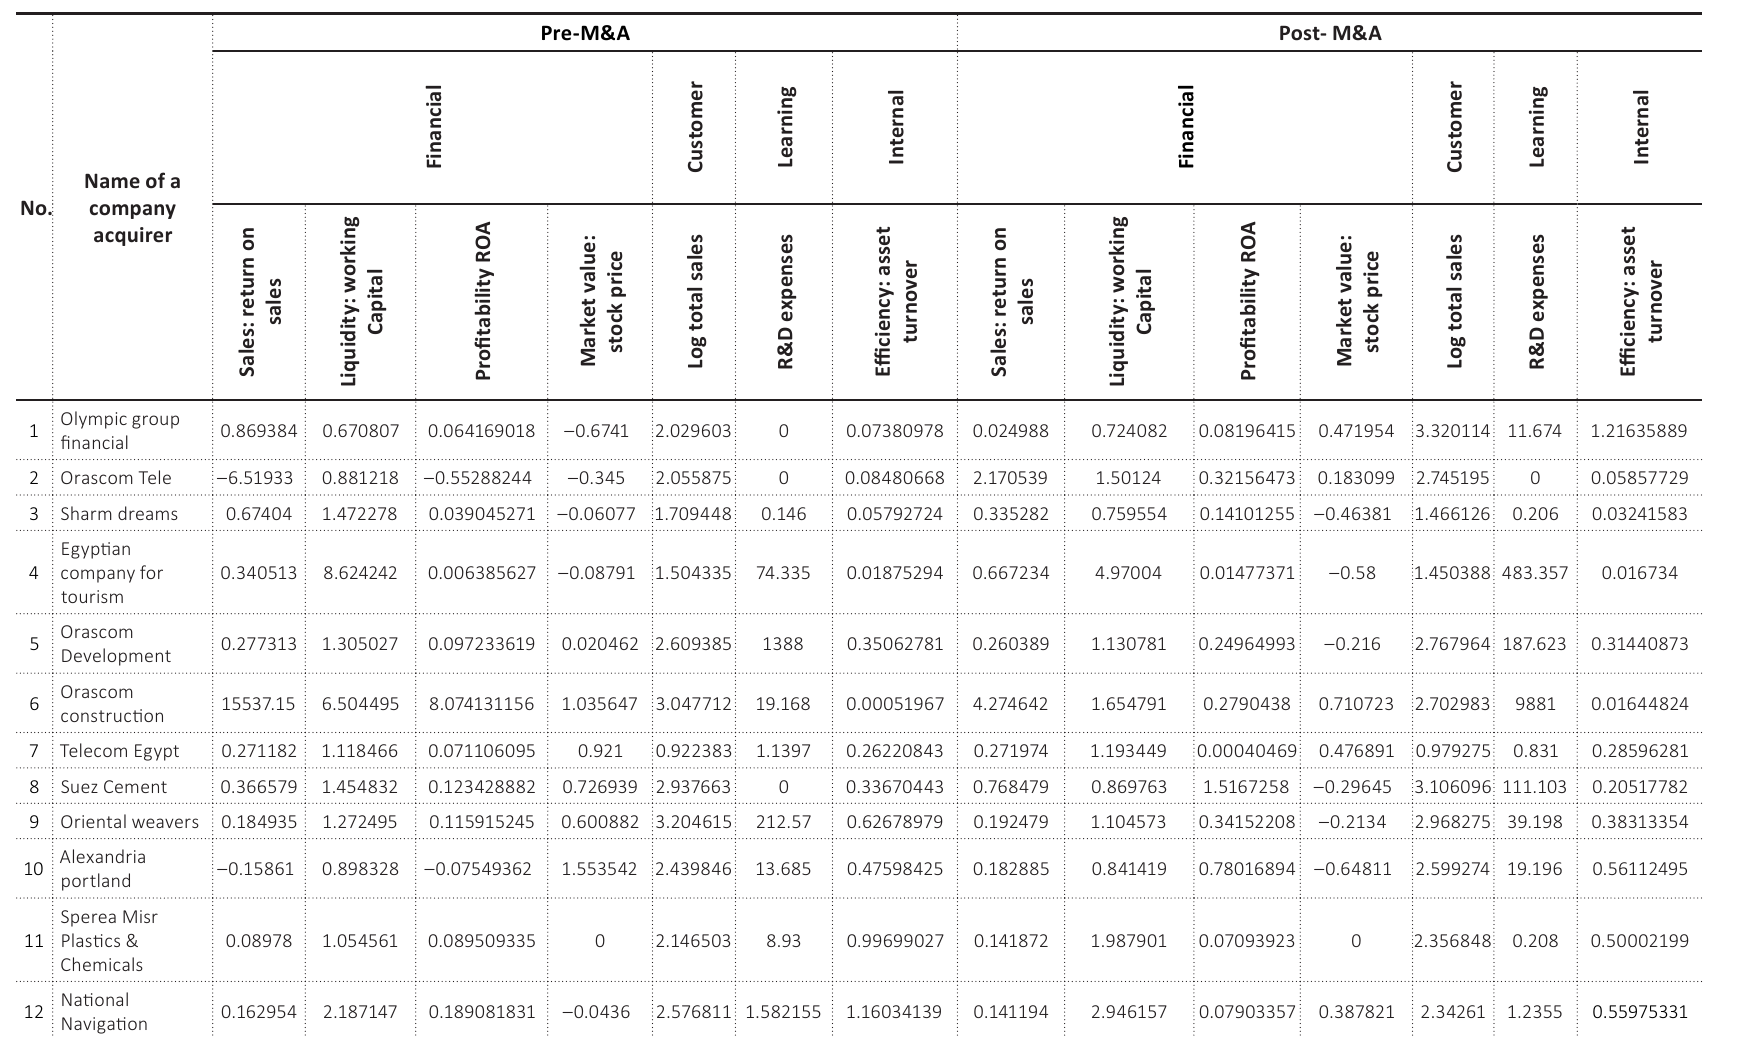
Table A1. Pre- and post-M&A BSC